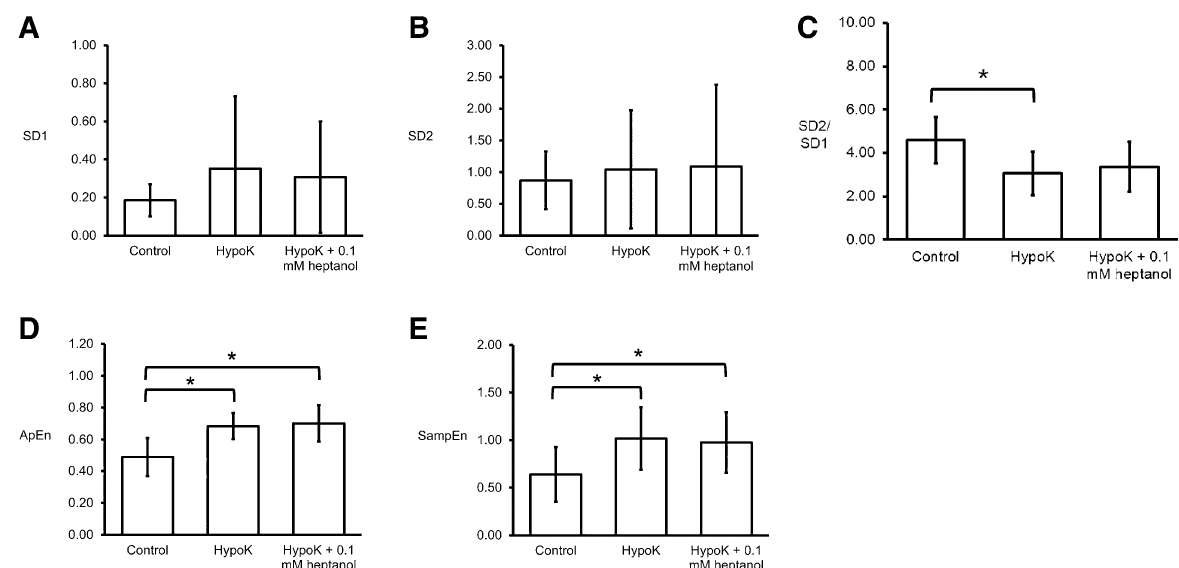
Fig. 6 Bar charts plotting SD perpendicular to the line-of-identity (SD1) ( A ), SD along the line-of-identity (SD2) ( B ), SD2/SD1 ratio ( C ), the approximate entropy ( D ) and the sample entropy ( E ) ( n